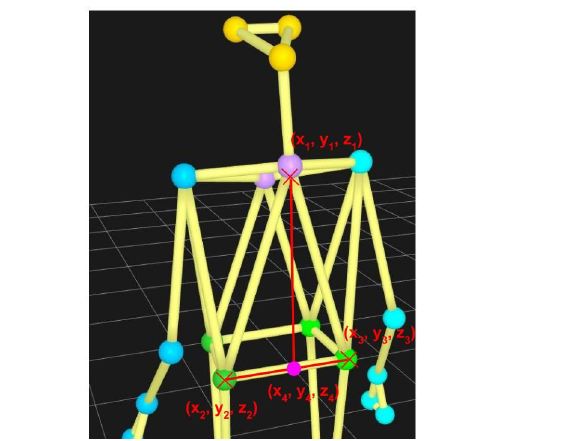
Fig. 5. Velocity during a punch. The blue line refers to participant #5 (high experienced), the red to participant #4 (intermediate level of experience) of the back is incorrect. Since each individual has a different length of the back, the values of Dist can be compared only when normalized. For each participant the mean µ Dist and the standard deviation σ Dist of all the Dist for each participant over time are computed. In order to compare participants, a measure of how large the standard deviation σ Dist is with respect to mean µ Dist is computed